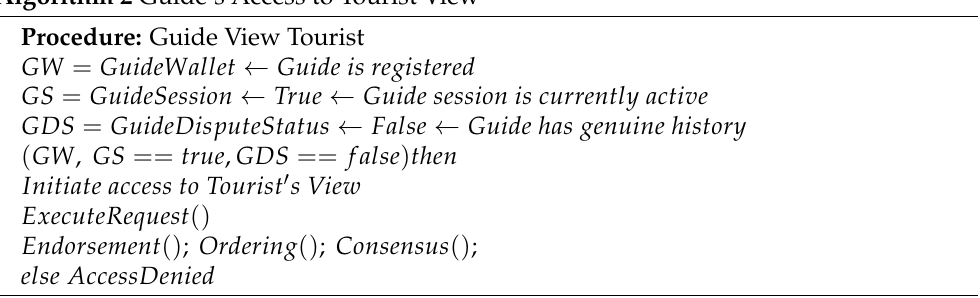
Algorithm 2 Guide’s Access to Tourist